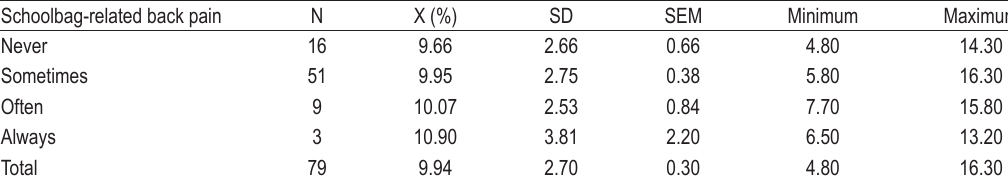
TABLE 8. Schoolbag weight (%) in relation to back pain Schoolbag‑related back